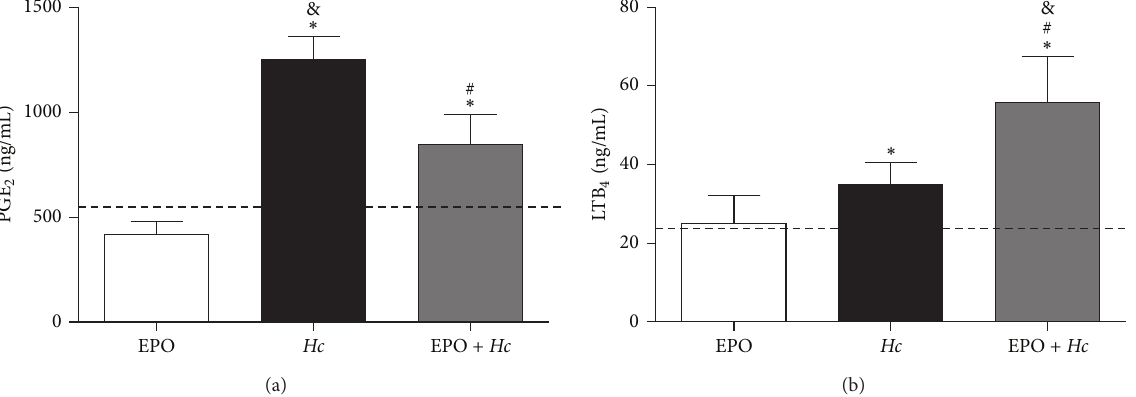
Figure 6: EPO pretreatment alters PGE 2 and LTB 4 production in lungs from Hc -infected mice. Lungs were removed from uninfected mice treated with 45 U EPO (EPO) or from untreated ( Hc ) or EPO pretreated ( EPO + Hc ) mice infected with Hc (5 × 10 5 yeasts/100 𝜇 L/mouse). Lungs were removed 14 days after infection and homogenized, and eicosanoids were purified as described in the Materials and Methods. PGE 2 (a) and LTB 4 (b) concentration was quantified in the purified homogenates by HPLC-MS/MS. Means ± SEM values from one representative experiment are shown ( 𝑛 = 4 –6). Newman-Keuls multiple comparison test was used and the differences were considered significant when 𝑝 < 0.05 . # Versus Hc ; ∗ versus uninfected and EPO-untreated (dashed line); & versus uninfected and EPO-treated